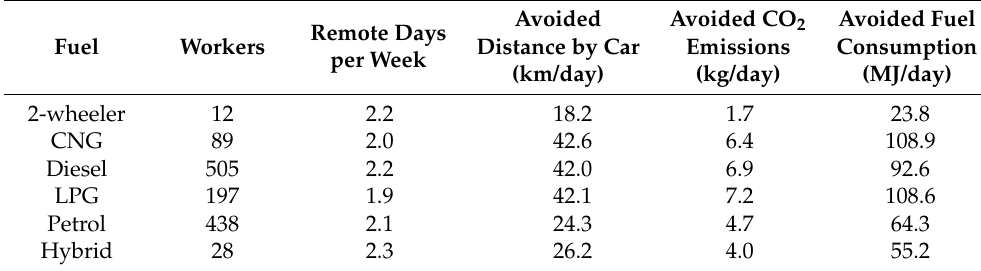
Table 6. Selected average indicators for remote workers travelling exclusively or partially by car for each